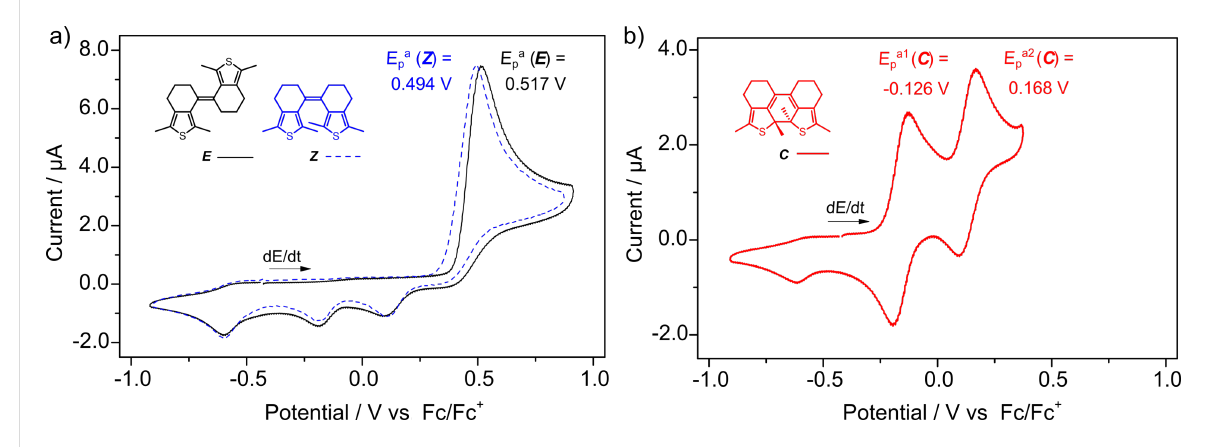
Figure 1: Cyclic voltammograms of sDTE 66 -Me . a) Both E- (black line) and Z- isomer (blue dashed line) display one irreversible oxidation wave, which is assigned to the formation of the closed isomer. b) The closed isomer (red line), generated in situ from Z- sDTE 66 -Me upon irradiation with 313 nm light prior to the CV measurement, displays two distinct oxidation waves. The first one is reversible whereas the second is quasi-reversible. Experi- ments were carried out in MeCN with 0.1 M Bu 4 NPF 6 , c = 1 ∙ 10 − 3 M, dE / dt = 1 V s − 1 .